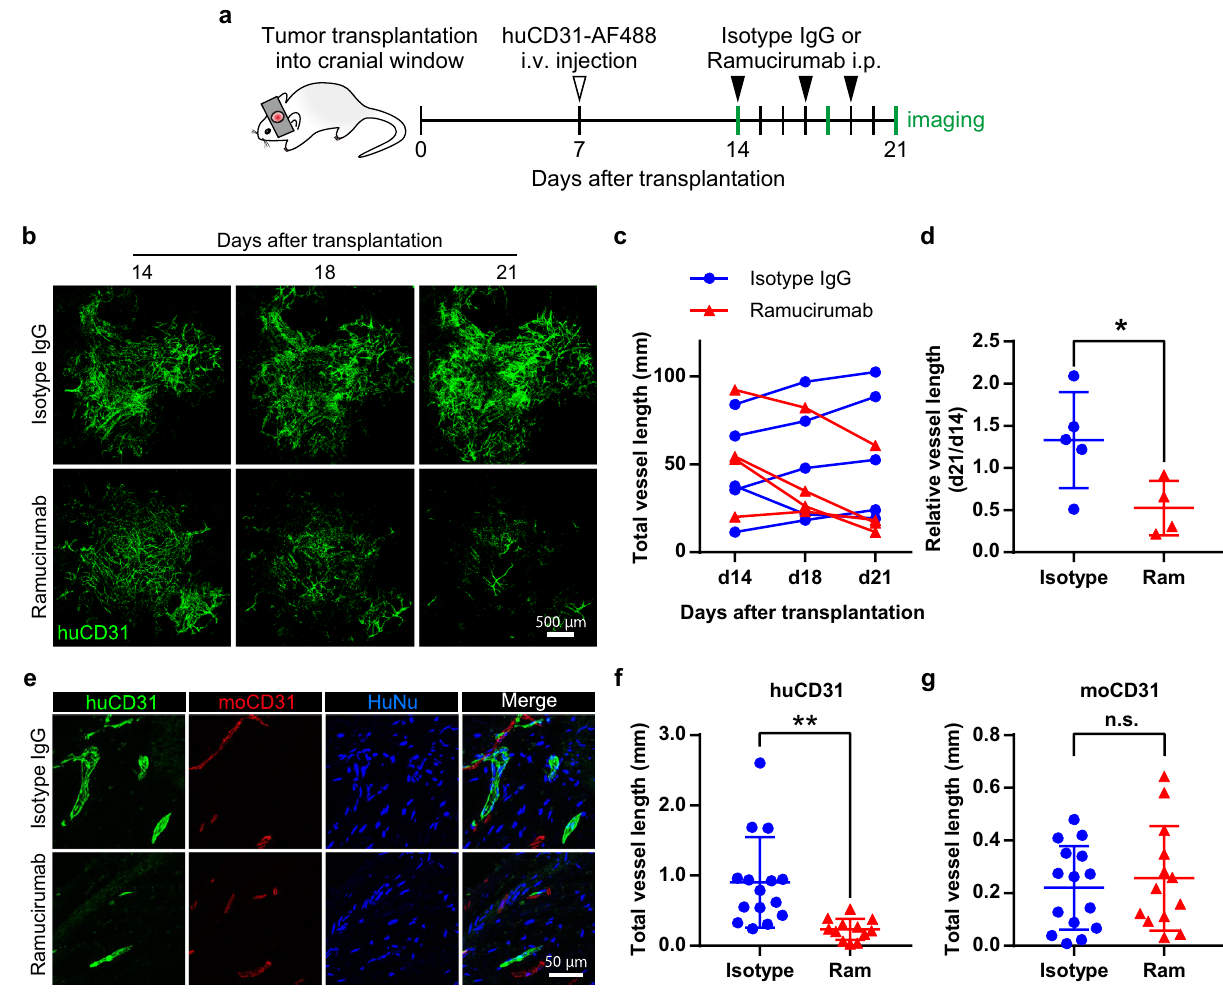
Figure 5. VEGFR2 inhibition causes regression of human blood vessels. ( a ) Schema for tumor transplantation into the cranial window and ramucirumab or isotype IgG treatment. b-d, VEGFR2 inhibition decreases human blood vessels. Representative images of huCD31-AF488-positive human blood vessels (huCD31, green) ( b ). Quantification of total human blood vessel length ( c ) and relative length ( d ) after ramucirumab (Ram) or isotype IgG (Isotype) treatment. ( e – g ): Transplanted tissues were sectioned for the analysis of human and mouse blood vessels. Representative images for the expression of human CD31 (huCD31, green), mouse CD31 (moCD31, red), and/or human nuclei (HuNu, blue) ( e ). Quantification of the total length of human ( f ) and mouse ( g ) blood vessels. Data are mean ± SD. (isotype IgG: n = 5, ramucirumab: n = 4). Welch´s t test was used to compare with isotype IgG-treated mice. *: p < 0.05. **: p < 0.01. n.s.: not